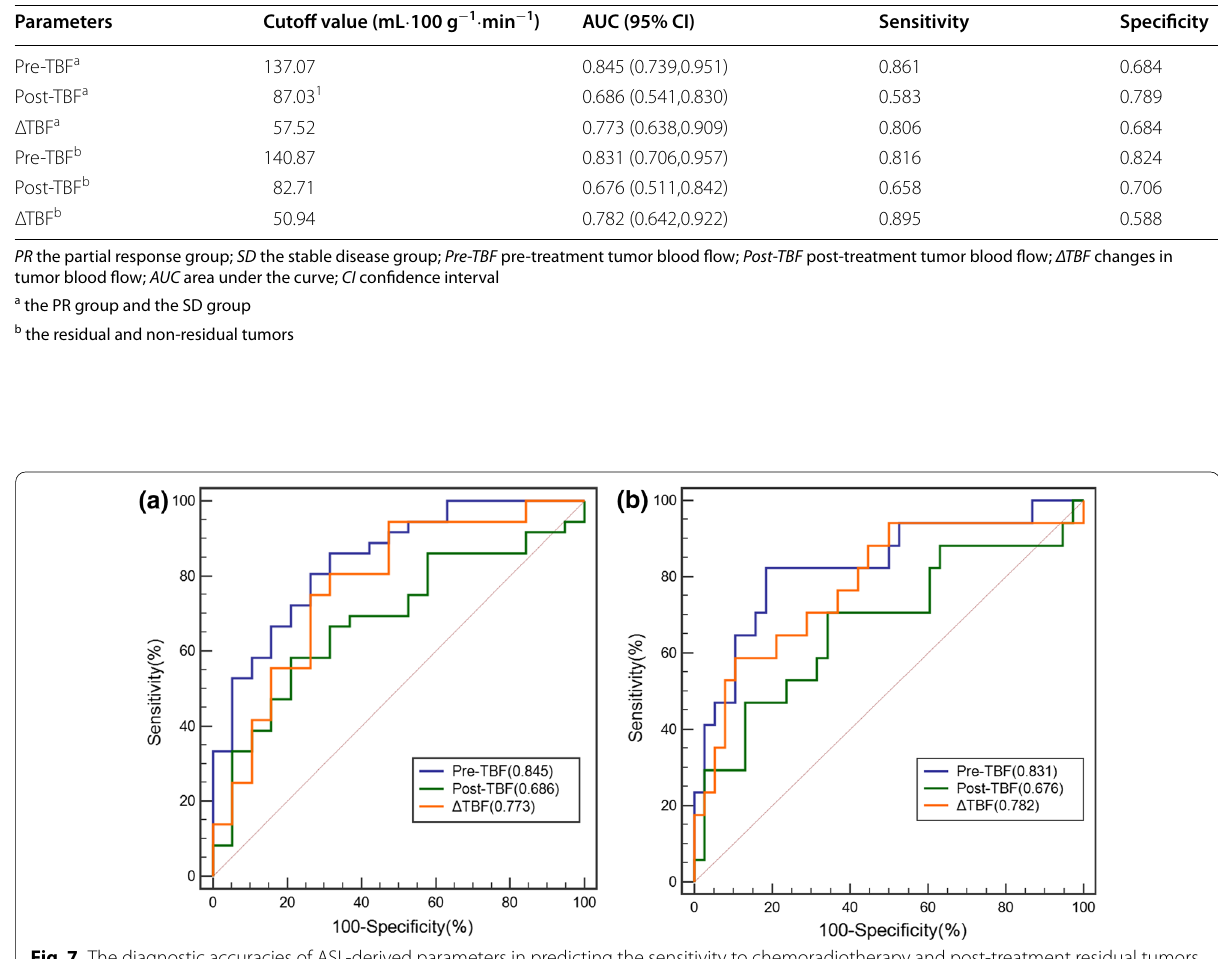
Table 5 Diagnostic efficacy of ASL-derived parameters in predicting PR and SD and residual and non-residual tumors